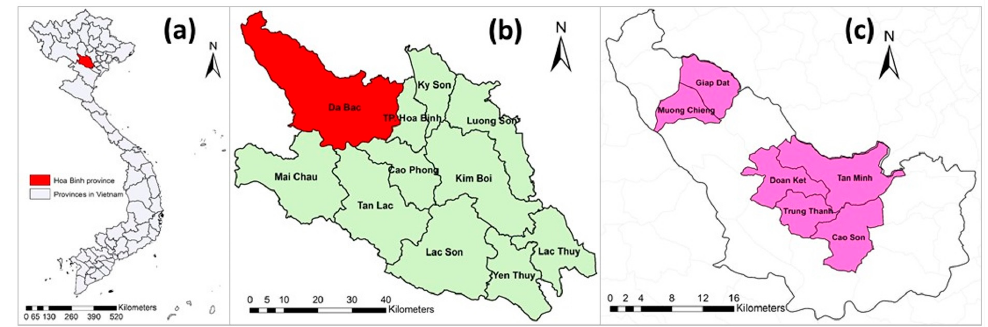
Figure 1. ( a ) Map of Vietnam with Hoa Binh province indicated; ( b ) Hoa Binh province and its districts; and ( c ) Da Bac district with six studied communes (pink).